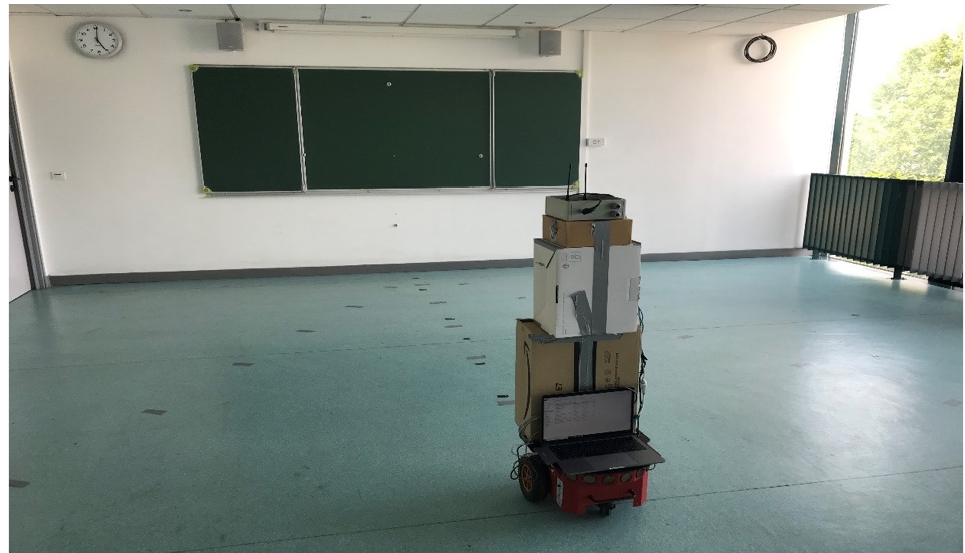
Figure 7. Experimental environment view.